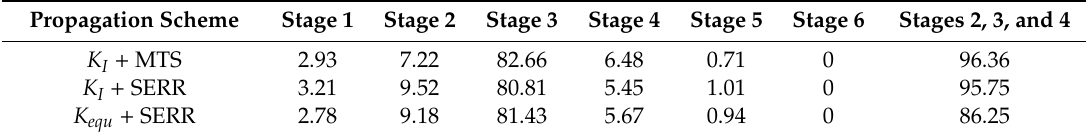
Table 6. Life ratio of di ff erent stages (%).